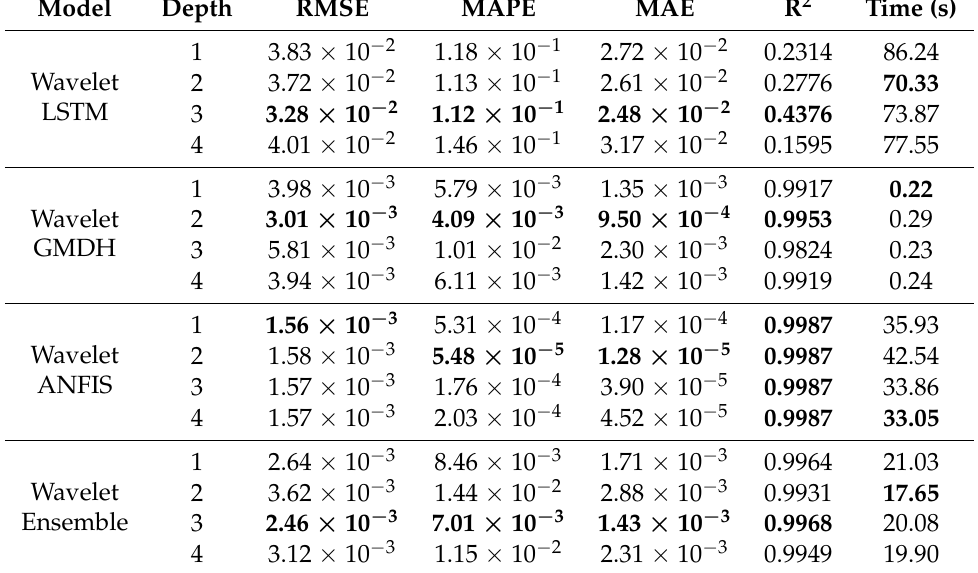
Table 7. Analysis using the wavelet transform.